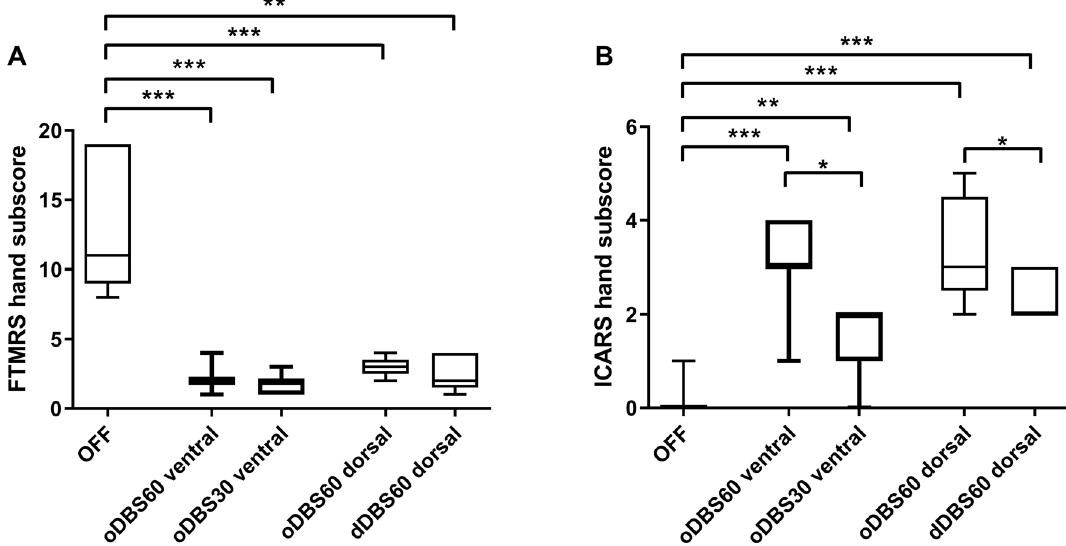
Figure 3. Effects of new DBS stimulation modes in PD patients. ( A ) Effect of the different DBS stimulation modes on tremor intensity measured by FTMRS. ( B ) Effect of the different DBS stimulation modes on ataxia assessed by ICARS. Stimulation modes: oDBS60 ventral: omnidirectional stimulation with 60 µs pulse width at the most ventral electrode contact, oDBS30 ventral: omnidirectional stimulation with the same energy dose equivalent amplitude at constant frequency with 30 µs at the most ventral electrode contact, oDBS60 dorsal : omnidirectional stimulation with 60 µs at the adjacent, second lowest, dorsal contact, dDBS60 dorsal: directional stimulation with 60 µs and the same amplitude as for omnidirectional stimulation at the dorsal contact. Asterisks indicate the different significance levels *p < 0.05, **p < 0.01, ***p < 0.001). All stimulation modes reduced tremor intensity compared to STIM OFF. The stimulation mode oDBS30 ventral induced less ataxia compared to oDBS60 ventral. Figure was created with GraphPad Prism (version 9 for Windows, La Jolla,